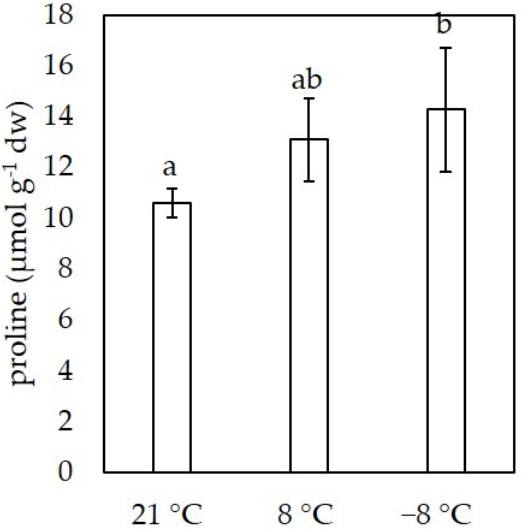
Figure 2. Proline content ( µ mol g − 1 dw) in flat leafe kale ( B. oleracea var. acephala ) sprouts at different temperatures. Value marked with different letters are significantly different at p < 0.05.